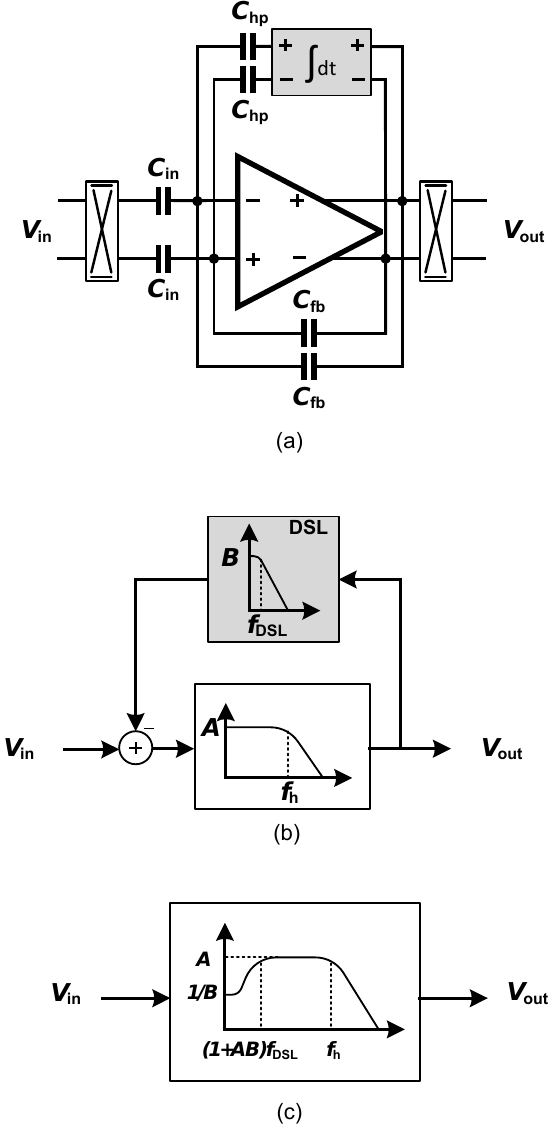
Figure 20. Effect of the dc servo loop on the overall frequency response of the chopper amplifier. ( a ) Topology including a dc-servo loop. ( b ) Block-level frequency responses of the topology including a servo loop. ( c ) Overall frequency